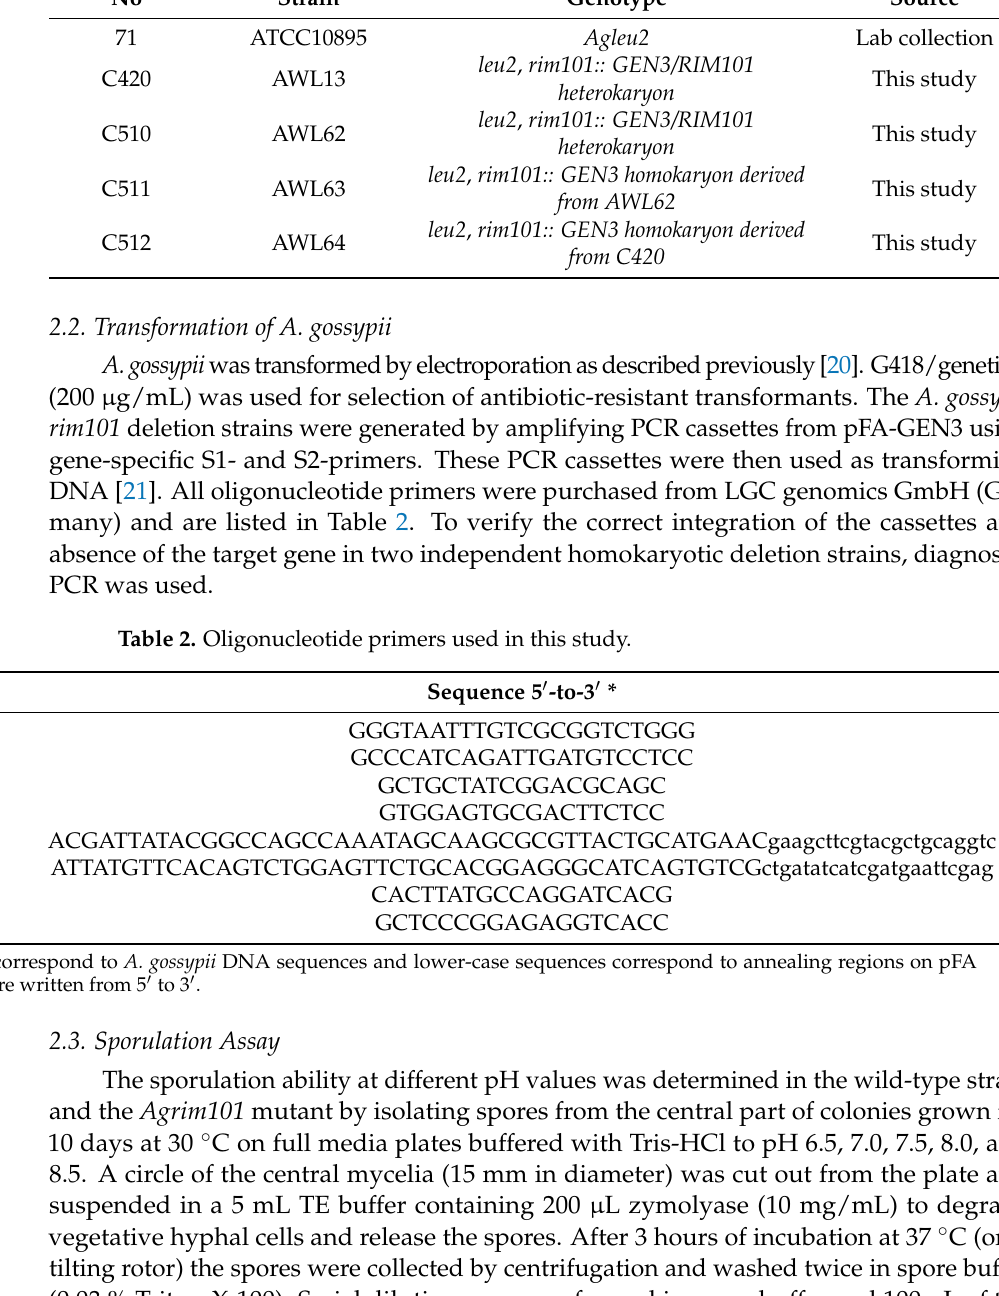
Table 1. Strains used in this study. A . gossypii strains used in this study. All strains are derivatives of Agleu2 . No Strain Genotype Source 71 ATCC10895 Agleu2 Lab collection C420 AWL13 C510 AWL62 C511 AWL63 C512 AWL64